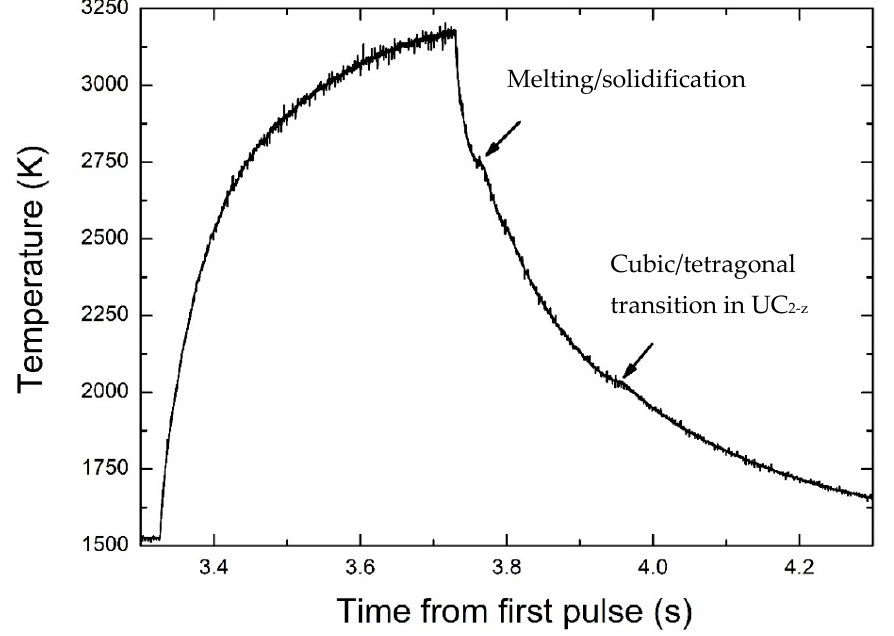
Figure 9. Thermogram of the UC 2 − y material for a 585 W laser heating 400 ms shot. Arrows indicate the positions of the thermal arrests.